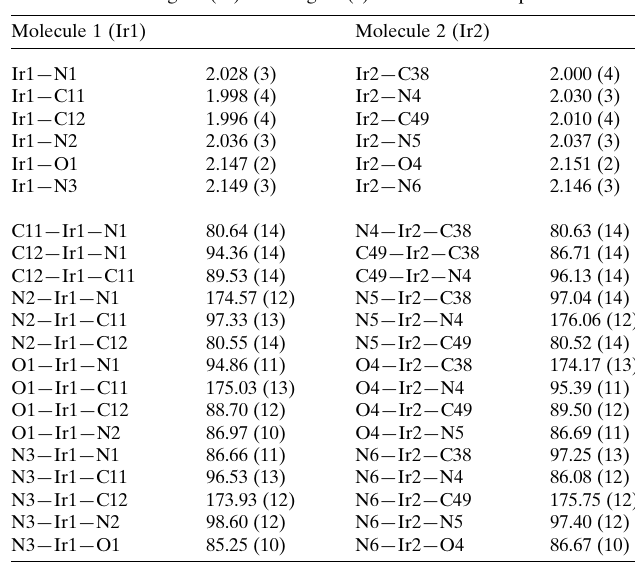
Table 1 Selected bond lengths (A˚ ) and angles ( (cid:3) ) for the title